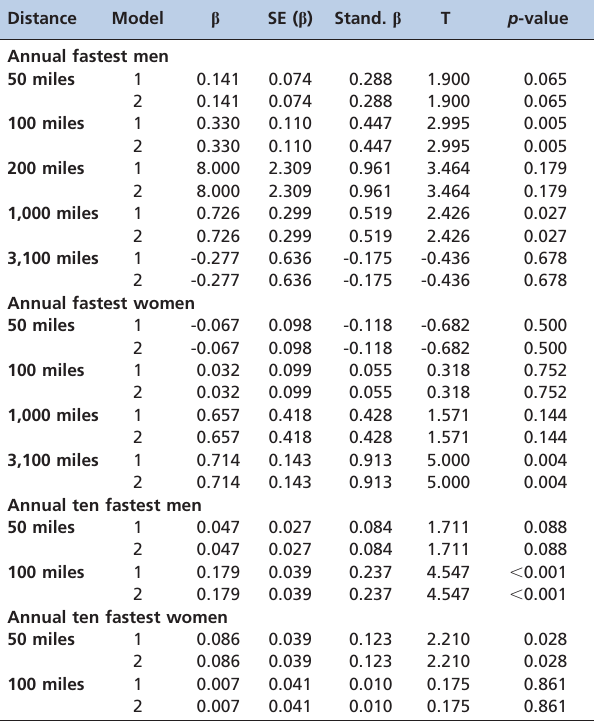
Table 3 - Multi-level regression analyses for change in age over time (Model 1) with correction for multiple finishes (Model 2) for the annual fastest and annual ten fastest women and